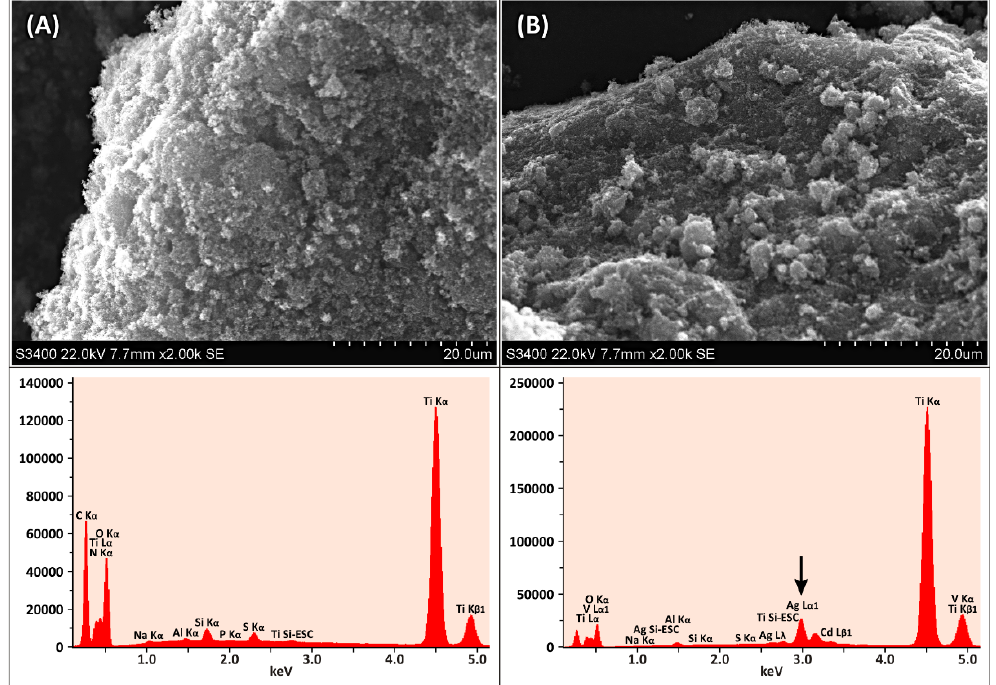
Figure 1. SEM micrograph and EDS analysis results of ( A ) TiO 2 and ( B ) Ag-doped TiO 2 particles.